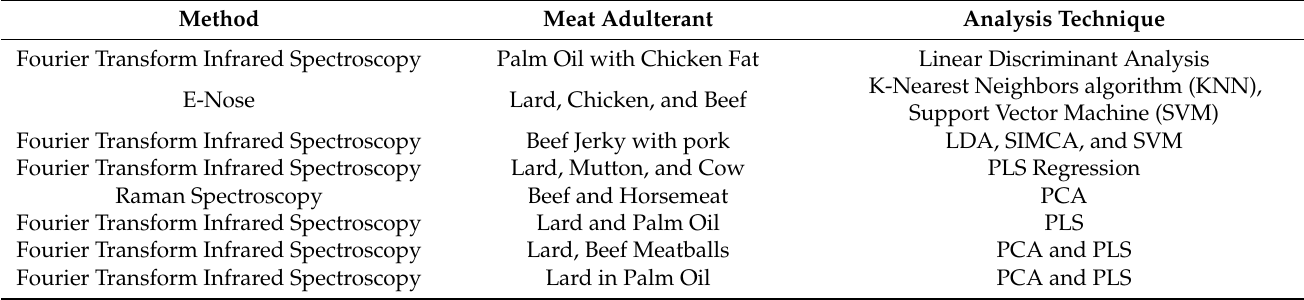
Table 1. Summary of food analyses using multivariate techniques with infrared spectroscopy for the detection of meat species adulteration